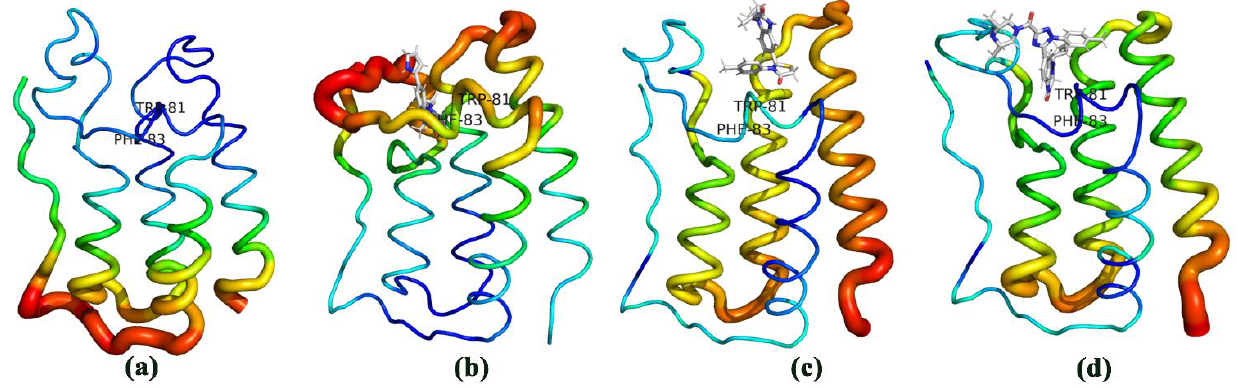
Figure 7. Motions of the four systems ( a ) Free-BRD4, ( b ) BRD4-Cpd4, ( c ) BRD4-Cpd9, and ( d ) BRD4- Cpd19. A thick red line represents a high B value and a thin blue line represents a low B value.